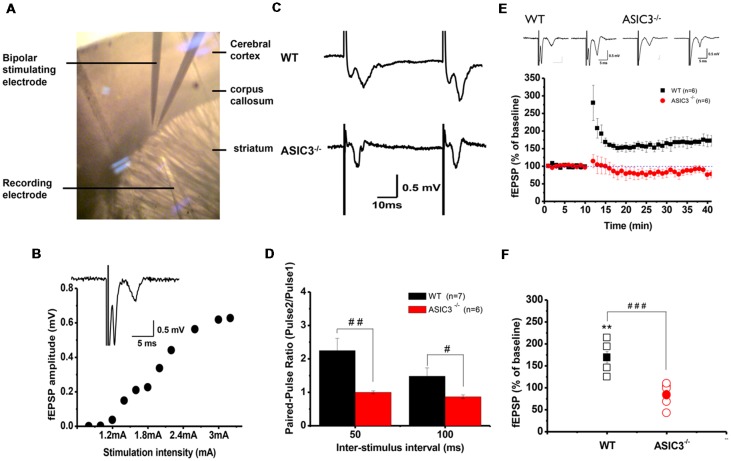
Electrophysiology properties of corticostriatal circuit in Asic3−/− and Asic3+/+ mice. (A) Recording setup of corticostriatal field excitatory post-synaptic potentials (fEPSCs) in sagittal brain slices. The recording electrode was placed in the dorsal striatum, and a bipolar stimulating electrode was placed in the corpus callosum to evoke fEPSPs. (B) fEPSP evoked in cortico-striatal synapses, and fEPSP amplitude plotted as a function of stimulus intensity showing gradually growing responses with increasing intensity. Inset shows a typical field recording. (C) Tracings represent the paired pulse response at 50-ms interval. (D) The averaged paired-pulse ratios (PPRs) of Asic3+/+ and Asic3−/− mice in 50- and 100-ms intervals (N = 6–7 mice per group). Paired pulse facilitation was significantly lower in Asic3−/− mice than Asic3+/+ mice (50 ms: t = 2.99935, df = 11, p = 0.00605; 100 ms: t = 2.04147, df = 11, p = 0.03297; #p < 0.05; ##p < 0.01). (E) High-frequency stimulation (HFS) of neocortical afferents could induce long-term potentiation (LTP) in the brain slices of Asic3+/+ animals. The cortico-striatal LTP was impaired in Asic3−/− slices. Upper panel shows the representative tracings before (in left) and after (in right) HFS of Asic3+/+ and Asic3−/− mice. (F) At 30 min after HFS, the mean fEPSP value was 84 ± 10% of pre-HFS values in Asic3−/− mice and 169 ± 13% of pre-HFS values in Asic3+/+ mice (Asic3+/+: pre-HFS vs. HFS: t = 5.30428, df = 5, p = 0.00318; Asic3+/+ vs. Asic3−/−: t = 5.08298, df = 10, p = 0.00605, p < 0.001; N = 6–7 mice per group. **p < 0.01 vs. pre-HFS, ###p < 0.001 vs. Asic3+/+). Data are mean ± SEM. Data analyzed by two-tailed unpaired t-test.